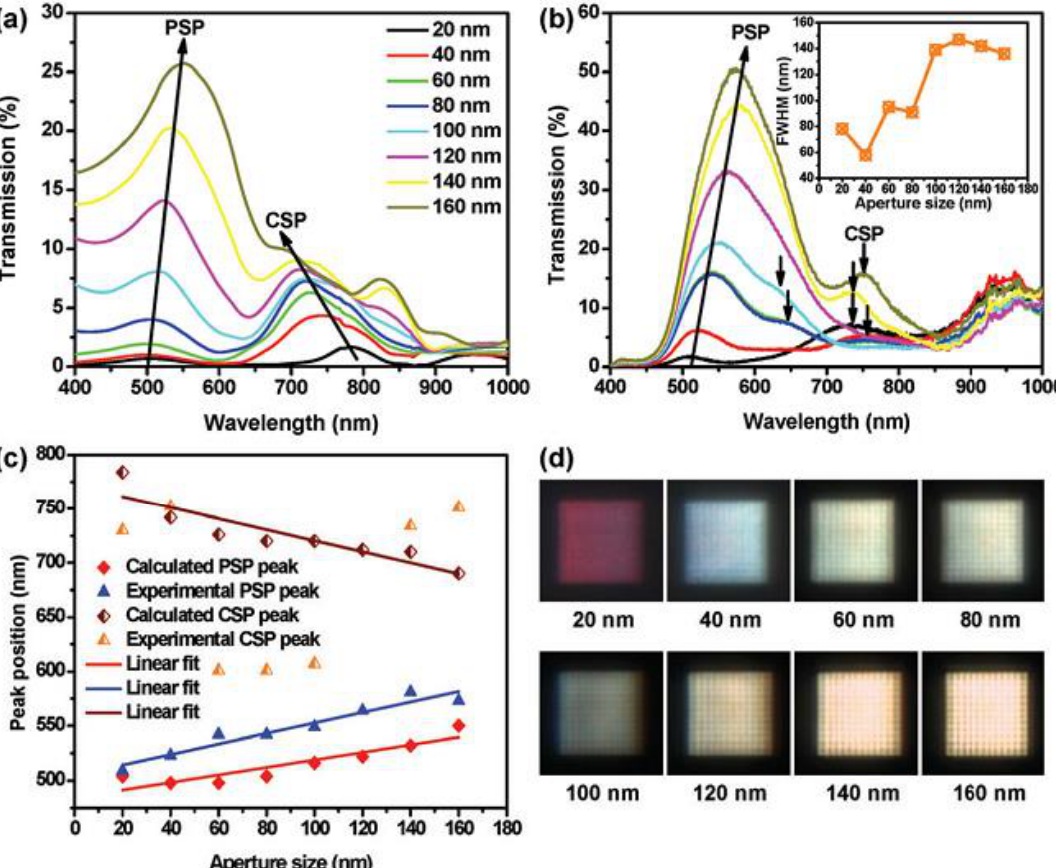
Figure 4. ( a ) Simulated and ( b ) experimental results of transmission for annular aperture arrays (AAAs) designed in a gold film. Aperture size increases from 20 nm to 160 nm in step of 20 nm. ( c ) Peak position as function of aperture size showing both cylindrical surface plasmons (CSPs) and planar surface plasmons (PSPs) peaks with linear fit. ( d ) CCD images captured by using an optical microscope. Reproduced with permission from [80]. Copyright John Wiley & Sons, 2012.